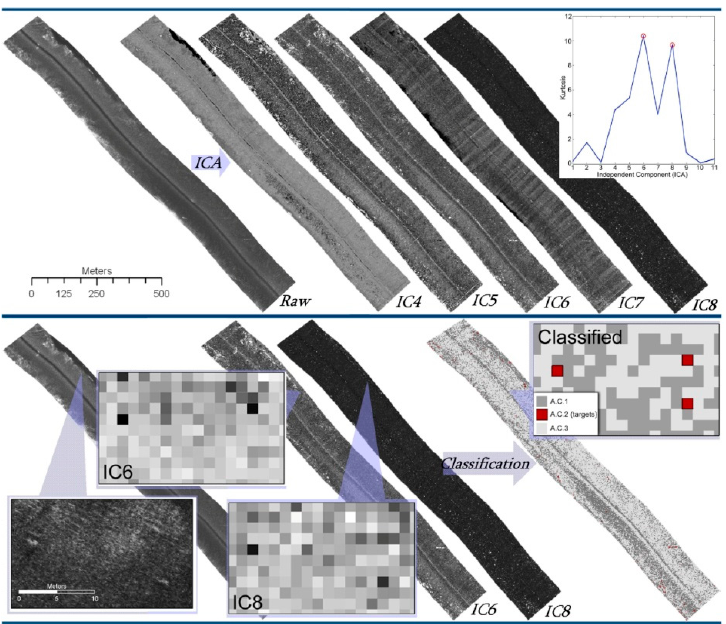
Figure 5. Illustration of the SSS image decomposition, component selection and clustering stages, as applied in a single sonograph of the case study. applied in a single sonograph of the case